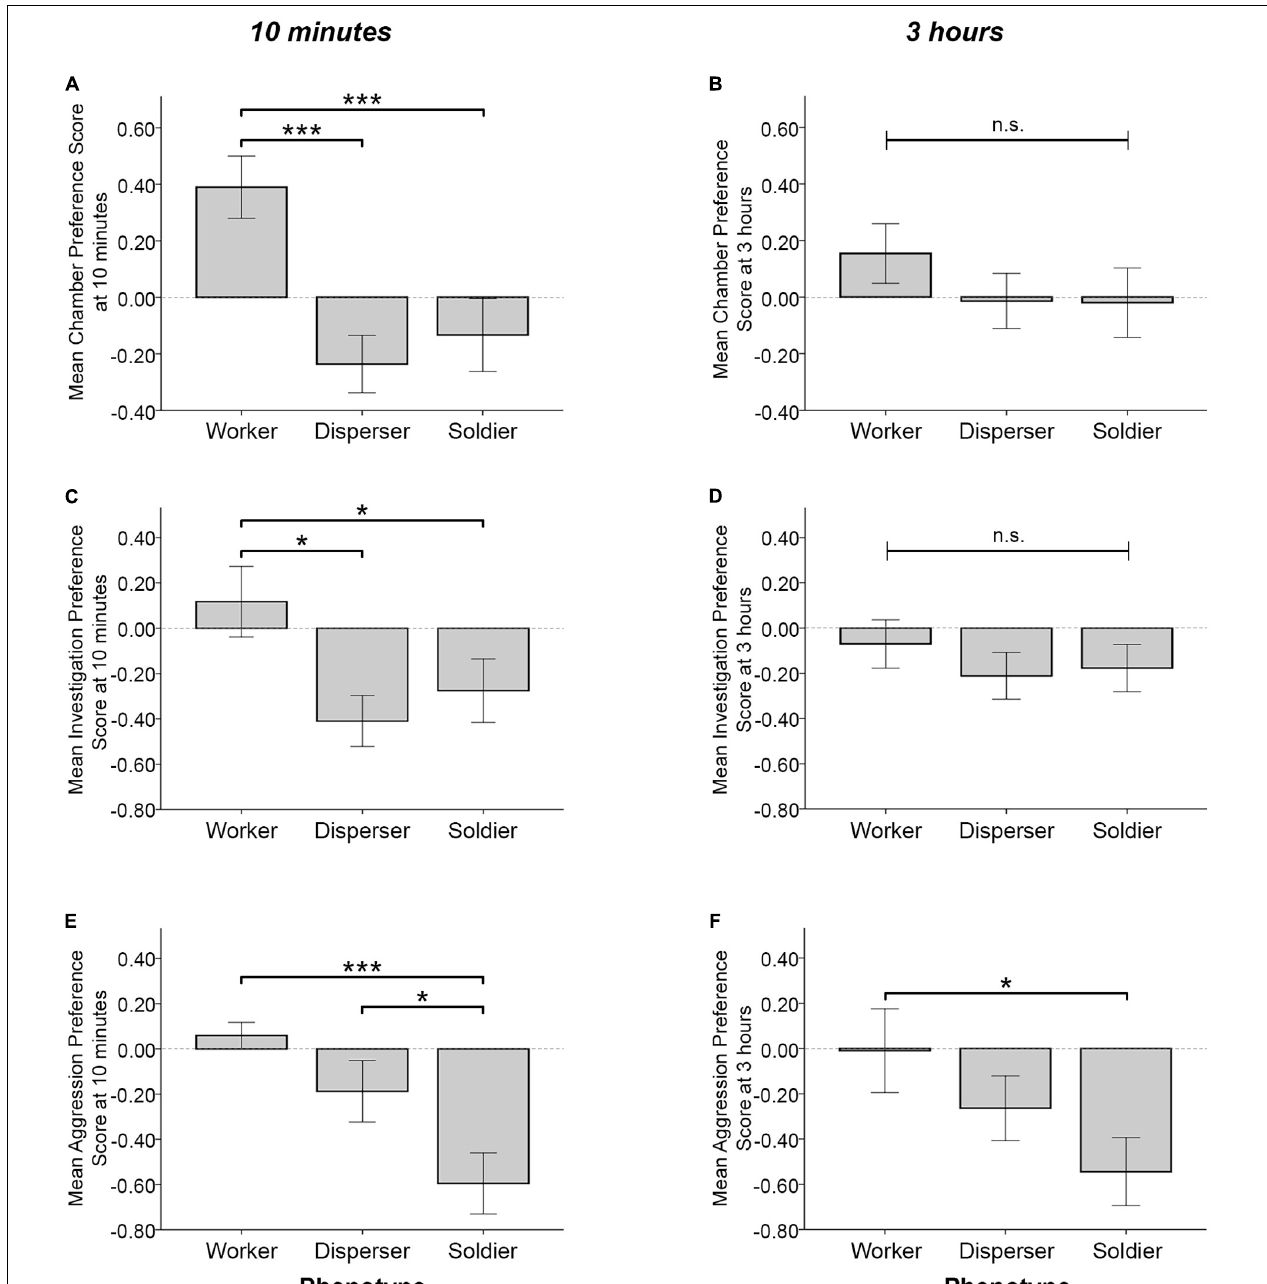
FIGURE 3 | Mean time in chamber, investigative behavior, and aggressive behavior preference scores ( ± SEM) for the first 10 min (A,C,E) and full 3 h (B,D,F) of the partner preference test. Workers had significantly higher chamber preference scores (positive score indicates preference for time spent in the familiar animal’s chamber) than did dispersers and soldiers at the 10 min time point (A) , but not at 3 h (B) . Workers ( n = 17) had significantly higher investigation preference scores (positive score indicates preference for investigating the familiar animal) than dispersers ( n = 16) and soldiers ( n = 20) at 10 min (C) , but not at 3 h (D). Soldiers had significantly lower aggression preference scores (a negative score indicates preference for aggression toward the unfamiliar animal) than did workers and dispersers at the 10 min time point (E) and following the full 3 h test (F) . n.s. = not significant, * p < 0.05, *** p < 0.001 for pairwise